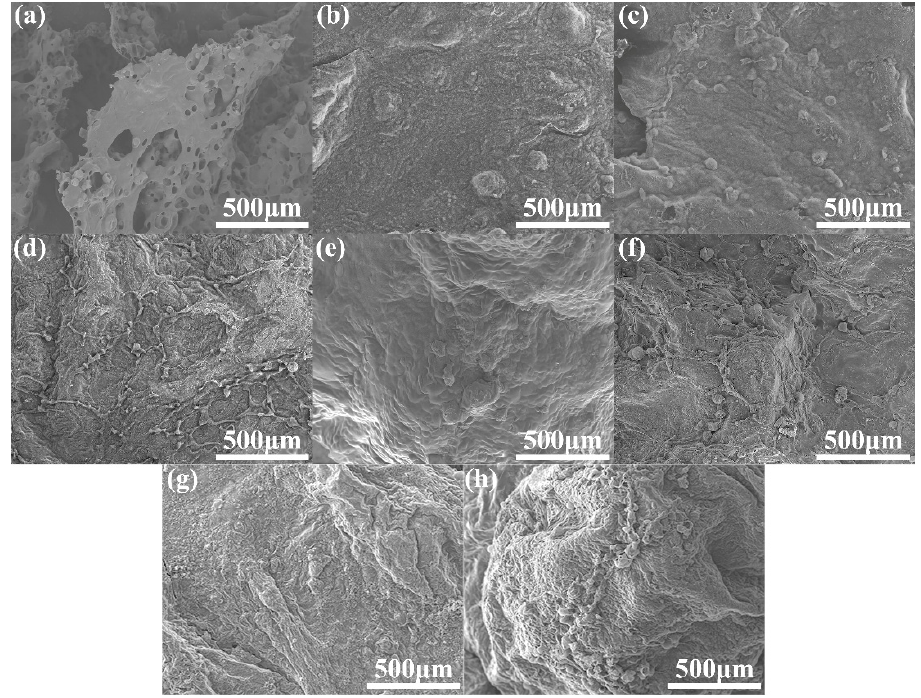
Figure 10. FSEM images of char residues of neat RPUF ( a ), RPUF-MOF/MWCNTs 1 ( b ), RPUF- MOF/MWCNTs 2 ( c ), RPUF-MOF/MWCNTs 3 ( d ), RPUF-T ( e ), RPUF-T/MOF/MWCNTs 2 ( f ), RPUF-C-MOF/MWCNTs 2 ( g ), and RPUF-T/C-MOF/MWCNTs 2 ( h ).